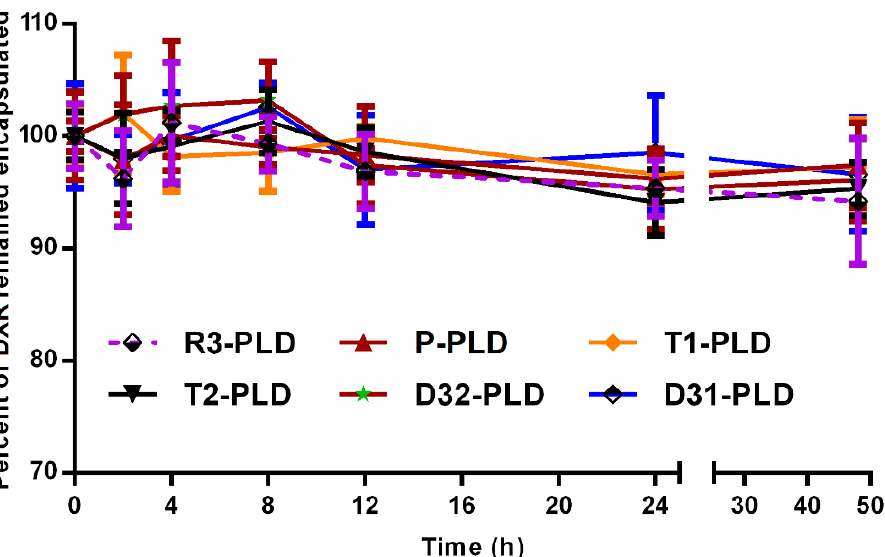
Figure 2. leakage stability assessment of different liposomal preparations at 37 °C in the presence of fetal calf serum (FCS). Diluted samples of liposomes were transferred to a dialysis cassette and dialyzed against 100 mL of sucrose 10% supplemented with 30% FCS at 37 °C. At different time points, the amount of doxorubicin released to the dialysis medium was determined, and the amount of DXR remaining encapsulated was measured. Data represented as mean ± SD ( n = 3).